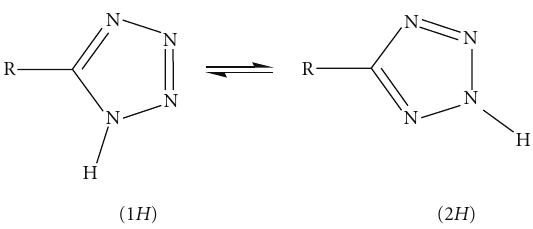
Scheme 1: The two possible tautomers of 5-substituted tetrazoles.